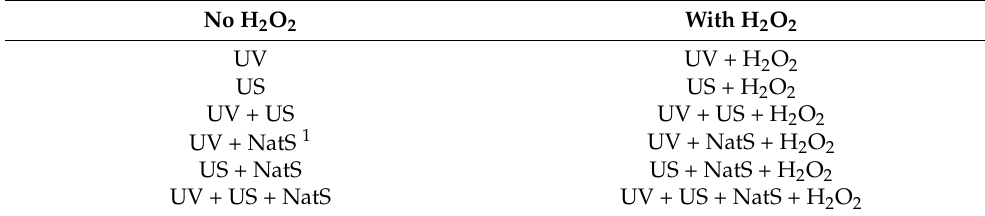
Table 1. Oxidation systems used in the